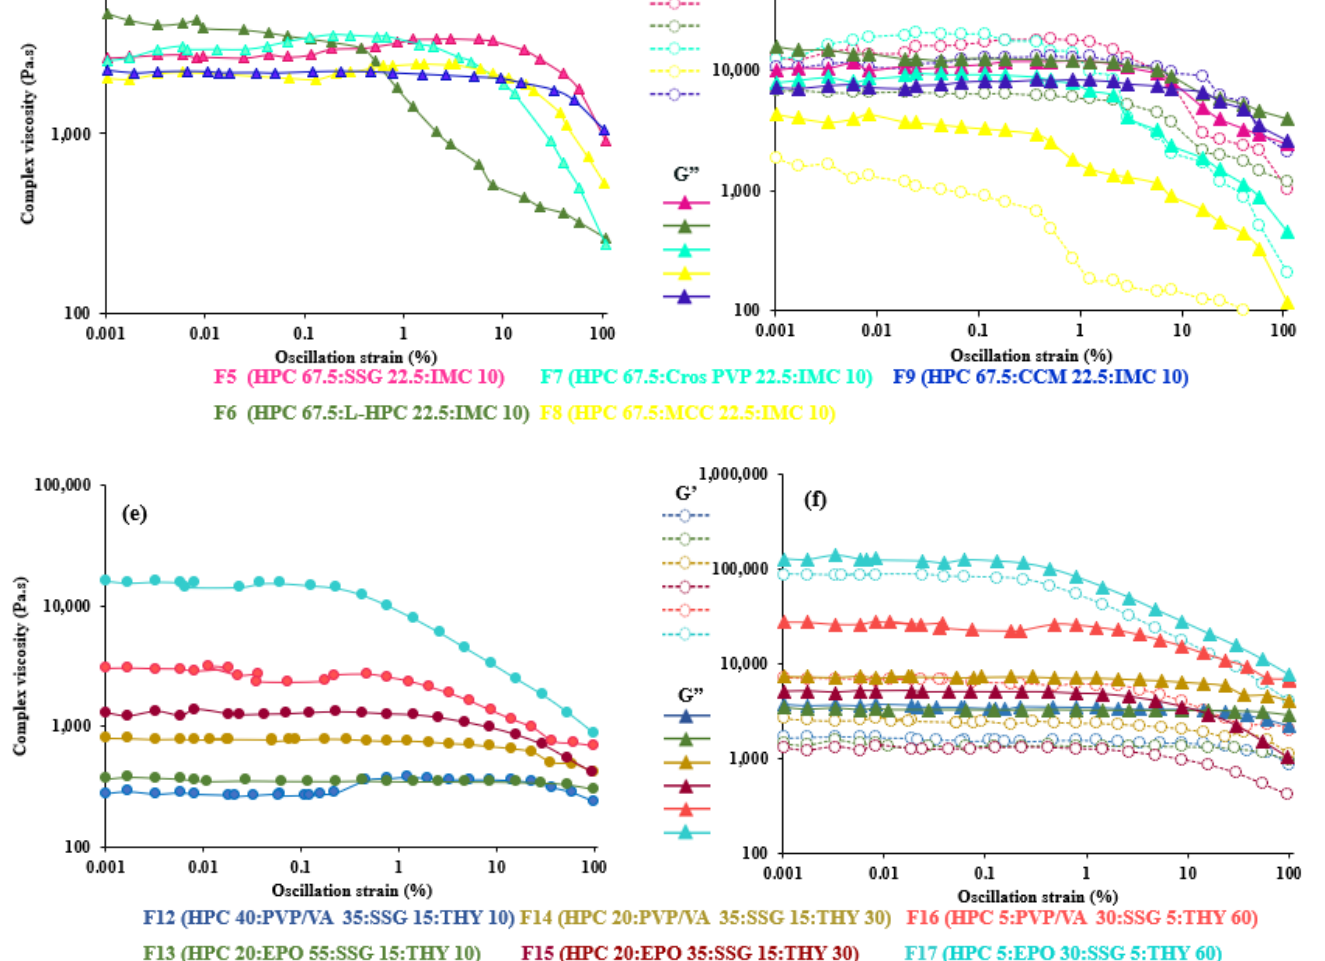
Figure 1. Effect of strain on complex viscosity ( left ) and storage (G’) and loss (G”) moduli as function strain ( right ) of ( a , b ) 67.5–45% HPC:polymer mixtures, ( c , d ) 67.5% HPC:disintegrant mixtures and ( e , f ) 40 – 5% HPC : polymer mixtures at 200 °C.